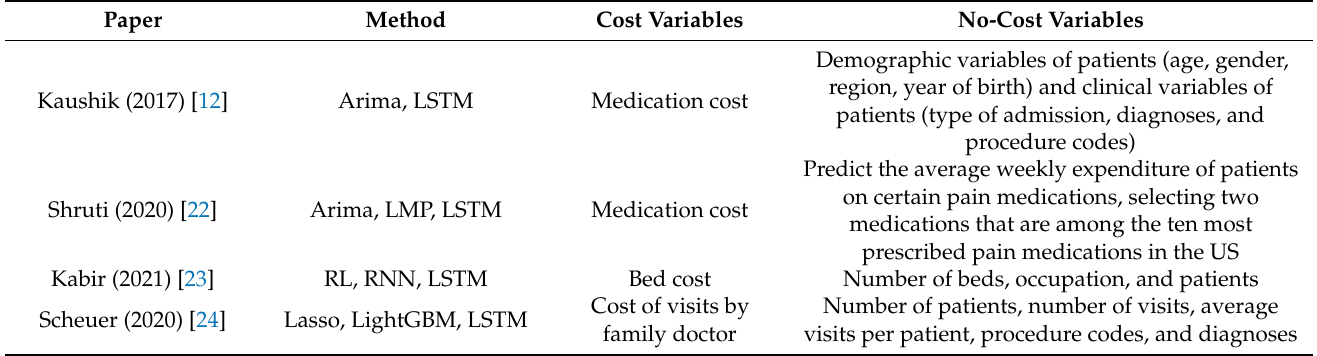
Table 1. Models and input variables from related